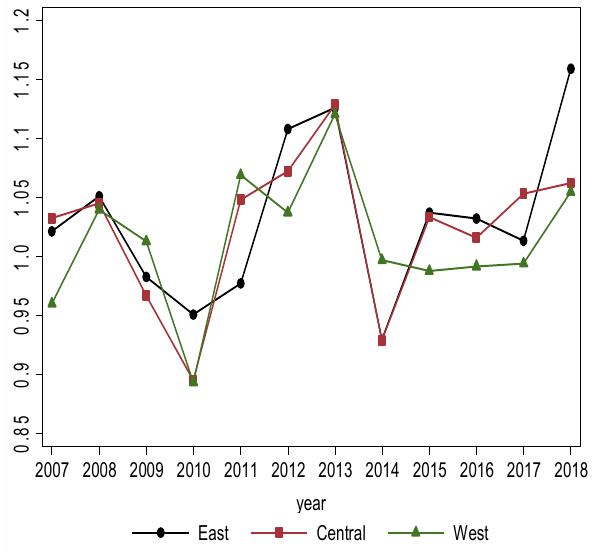
Figure 2. Trends in Rice Production Efficiency by Regions, 2007–2018.